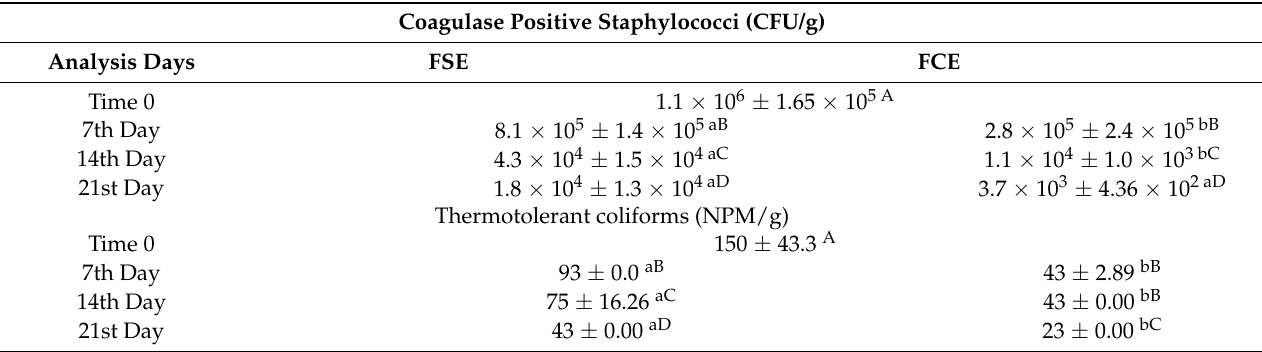
Table 9. Microbiological stability in